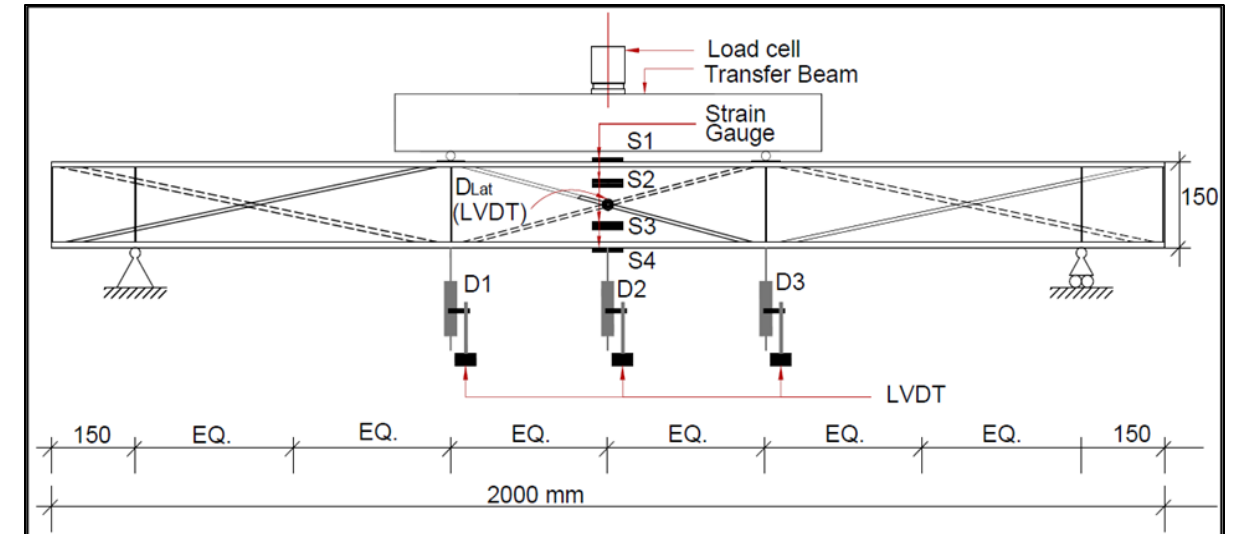
Figure 3. Schematic diagram of the experimental setup.